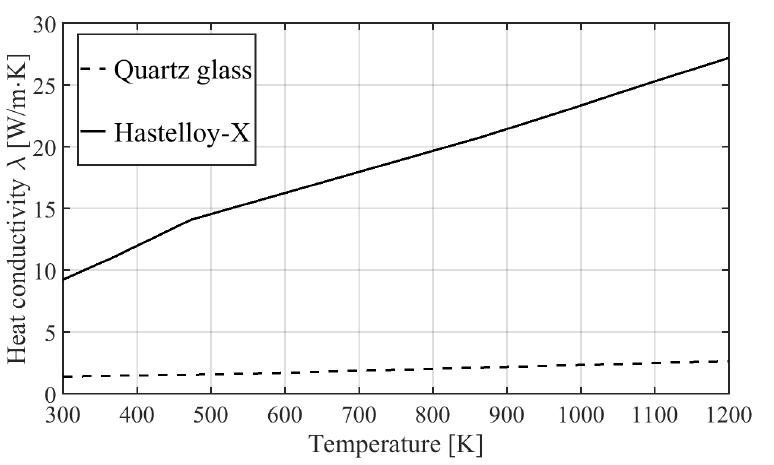
Figure 3. Used region-wise linear approximation of thermal dependency of solid structure materials’ thermal porperties. Example for thermal conductivity of hastelloy and quartz glass as employed in the coupled simulations. Adapted from